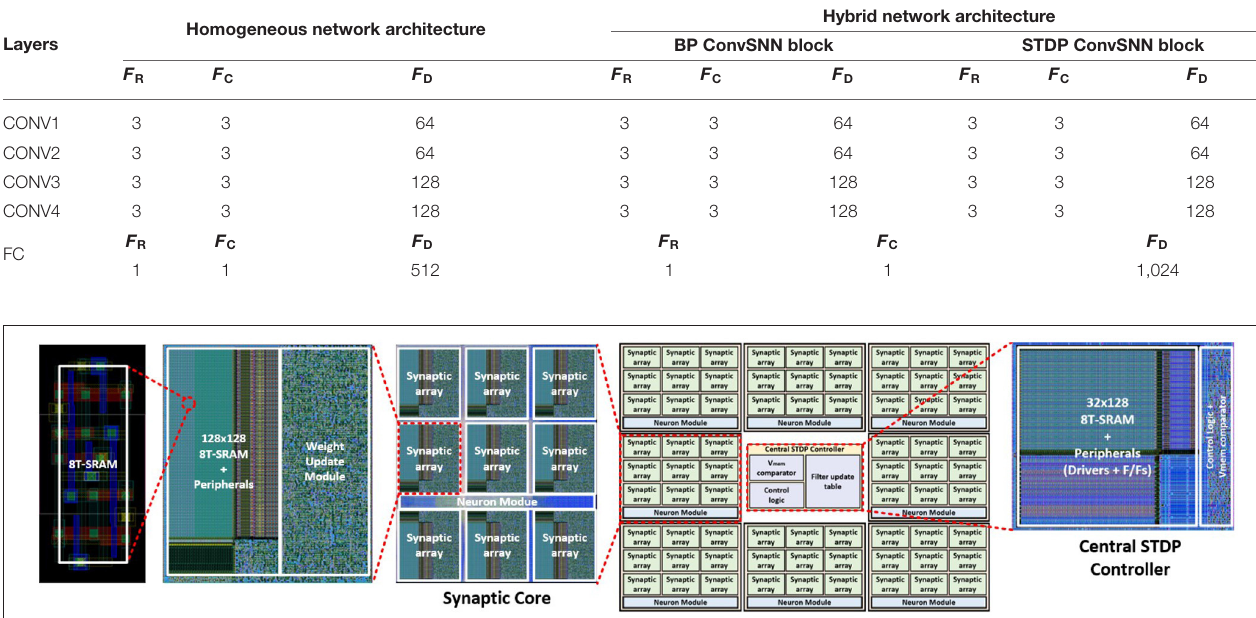
TABLE 1 | Architecture and parameters of the tested convolutional neural network within spiking neural network (ConvSNN) networks.